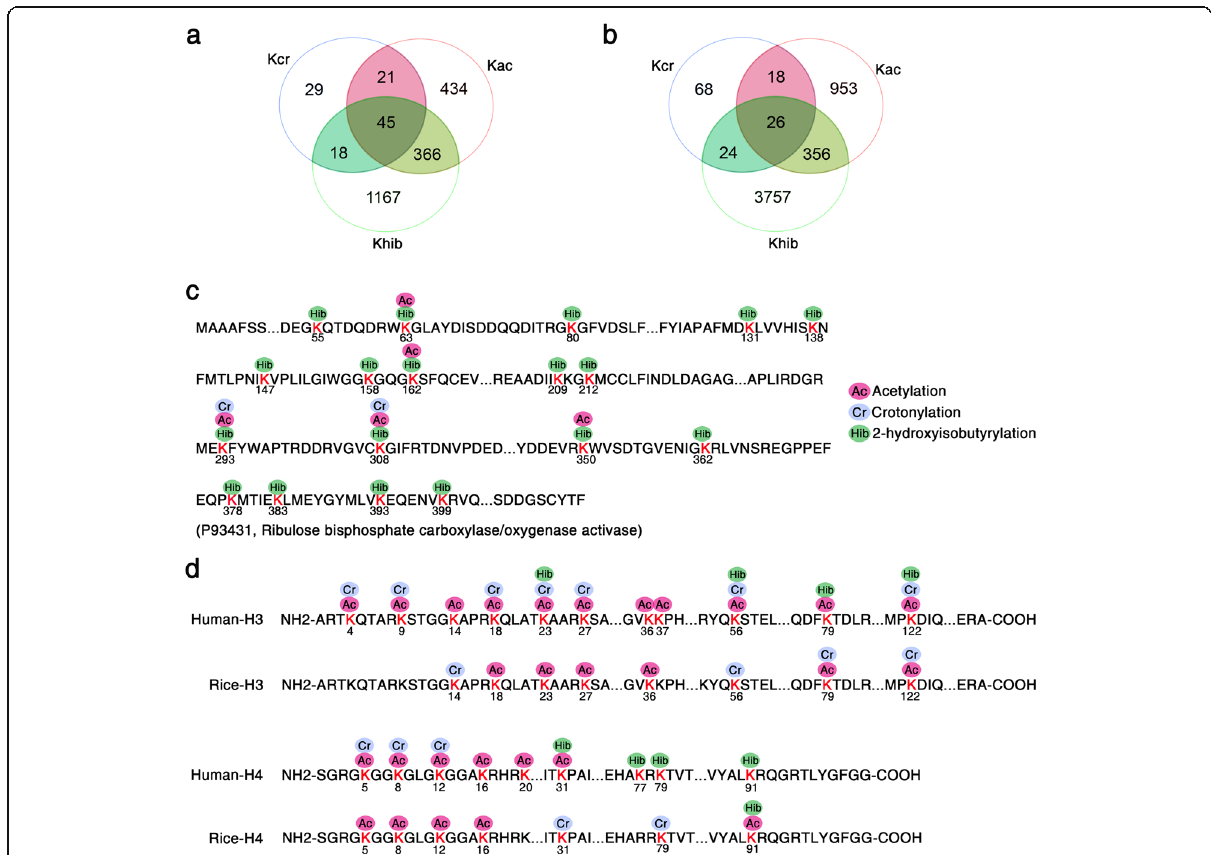
Fig. 6 Comparison of the 2-hydroxyisobutyrylome with the lysine acetylome and lysine crotonylome in rice leaves. a The overlapped number of Khib proteins among Khib, Kac, and Kcr. b The overlapped number of Khib sites among Khib, Kac, and Kcr. c Khib, Kac, and Kcr sites on the representative protein Rubisco activase (P93431). d Comparison of histone H3 and H4 with Khib, Kac, and Kcr sites between rice and